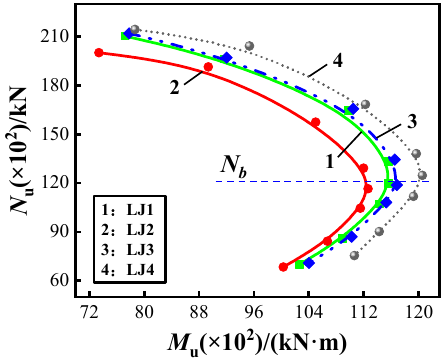
Figure 25. N–M curves for different pitches.